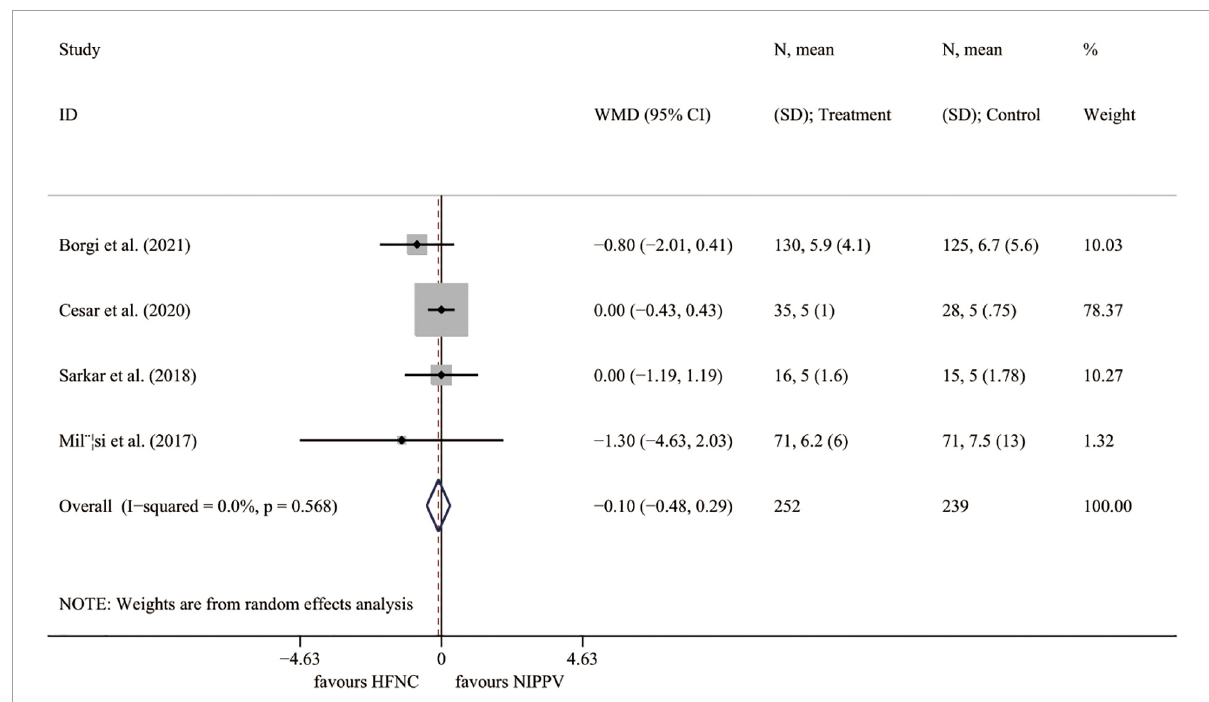
FIGURE5 Forest plot for PICU length of stay. PICU, pediatric intensive care unit; WMD, weighted mean difference; HFNC, high flow nasal cannula; NIPPV, non-invasive positive pressure